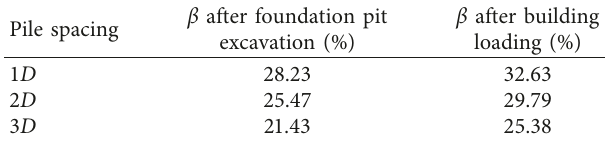
Table 11: Reinforcement effects of isolation piles on torsional deformation of the tunnel structure under different isolation pile spacing.